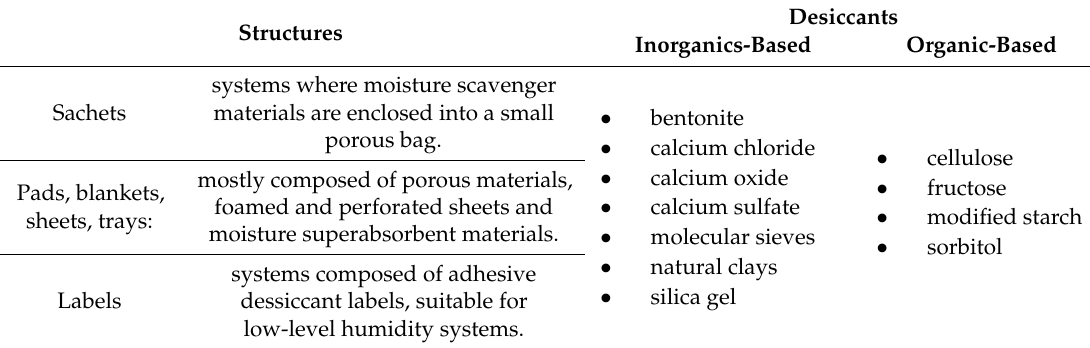
Table 2. Main features of commercially available systems working as moisture